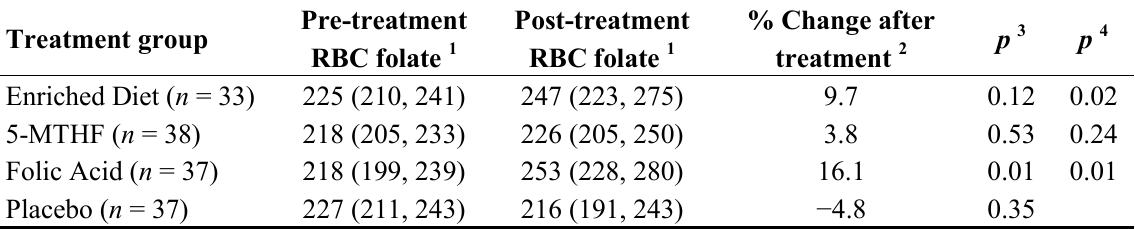
Table 5. Distribution of serum RBC levels before and after the intervention according to treatment